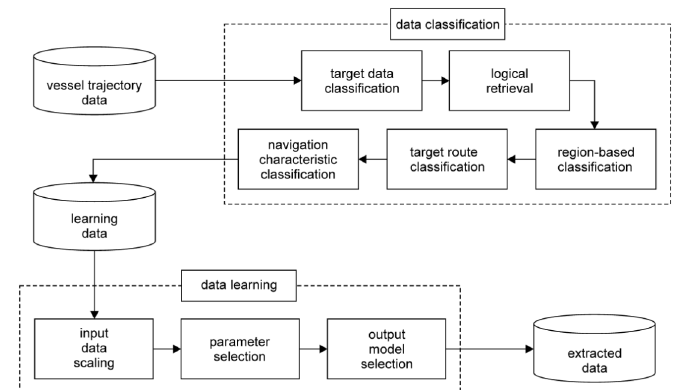
Figure 1. Support vector regression (SVR) seaway model